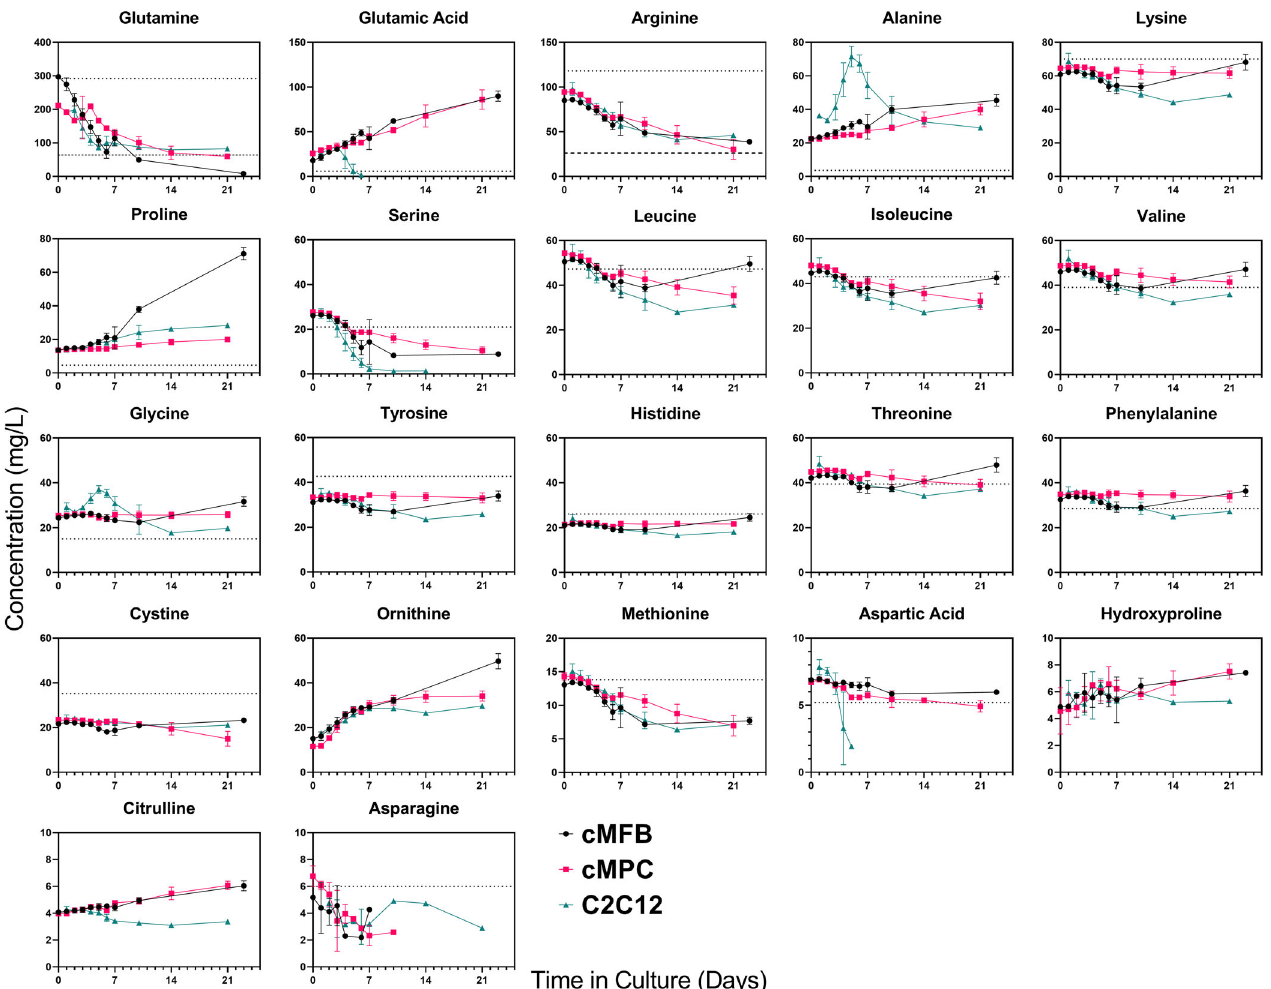
Fig. 2 Amino acids. Analysis of amino acid concentrations in spent media from cultures of three cultivated meat-relevant cell types. Dotted lines represent expected concentrations of the amino acids based on the contributions from the basal media formulation consisting of 40% DMEM and 40% F10. The contribution from the 20% of fetal bovine serum in the media is not considered in the estimated expected starting concentrations. Data points represent the mean of three biological replicates ± standard deviation. The ranges of the y -axes for the graphs are not all the same. cMFB primary embryonic chicken muscle fi broblasts. cMPC primary embryonic chicken muscle precursor cells. C2C12 murine myoblast-like cell